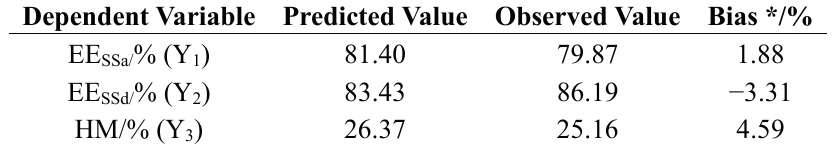
Table 8. Model-predicted and observed values of entrapment efficiency of SSa and SSd, the hemolysis according to the optimal experimental conditions (X 1 = 26.71, X 2 = 4, X 3 = 50 °C) ( n = 3).